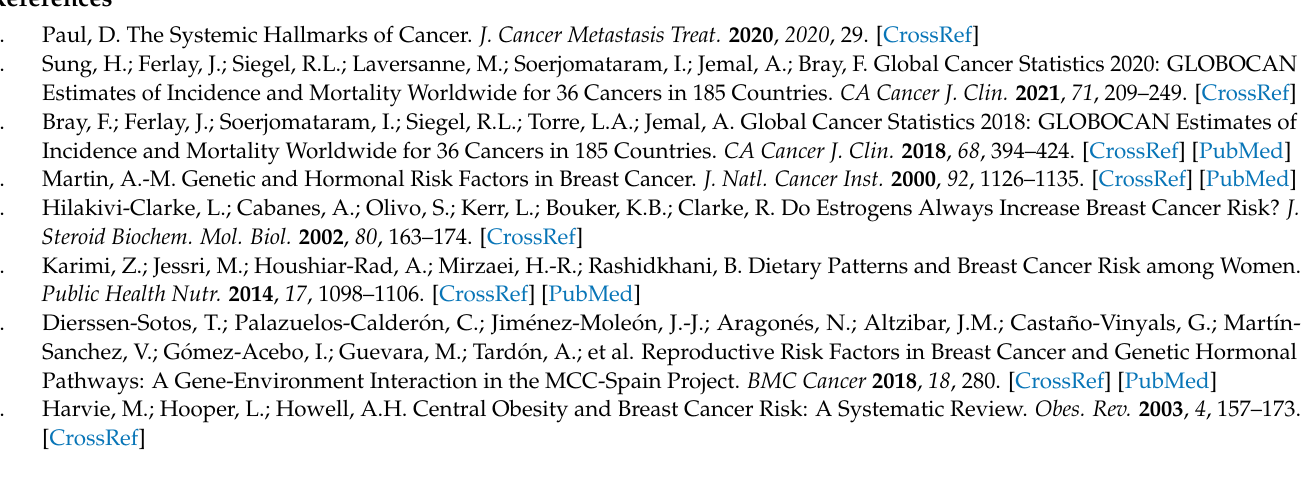
Figure S2: IR spectrum of policaprolactona 1800–650 cm − 1 . Table S1: Data of the cytotoxicity tests with the respective statistical